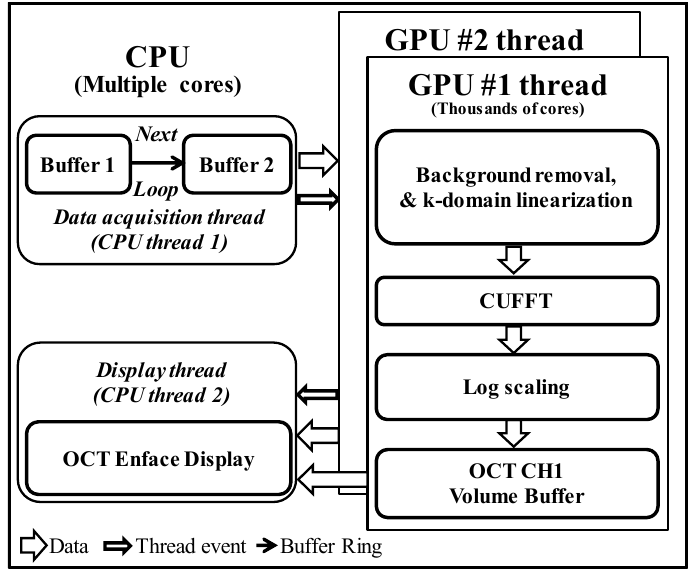
Figure 3. GPUs signal processing architecture of the proposed industrial SD-OCT system for optical thin film inspection.